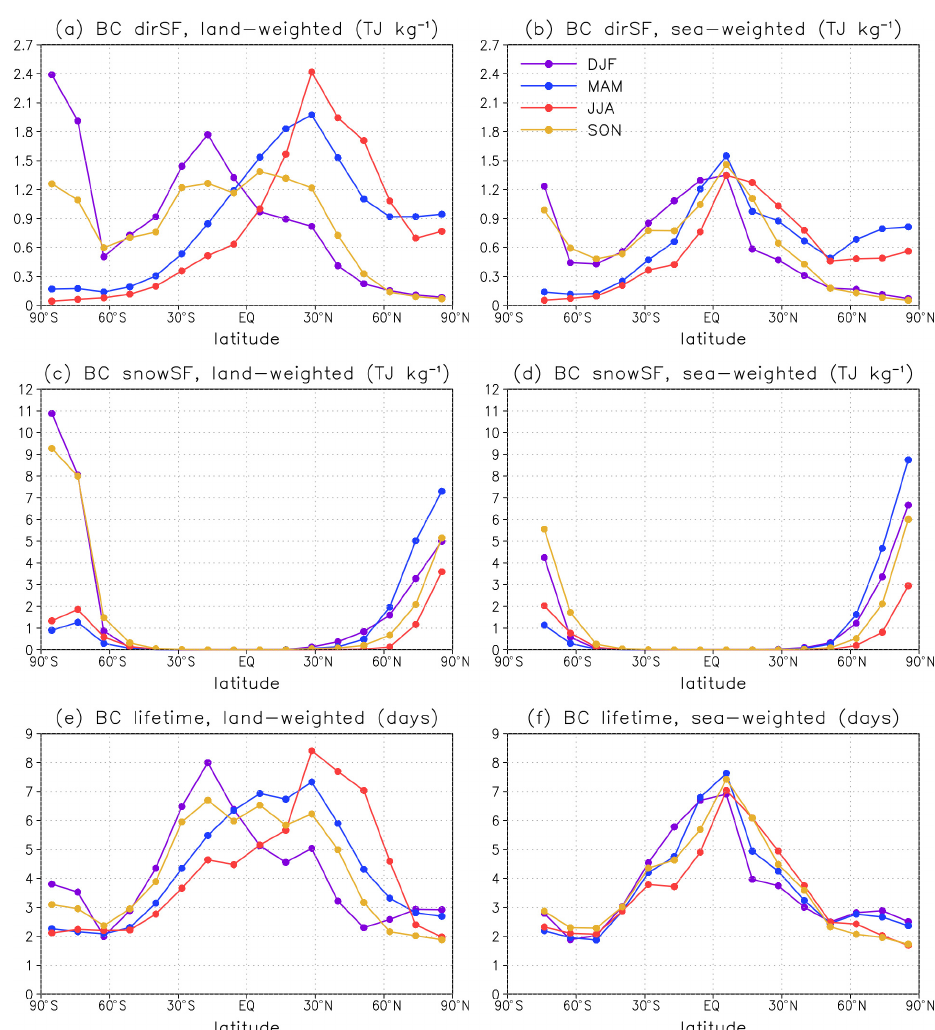
Figure 6. Global mean BC direct specific forcing (TJkg − 1 ) associated with BC emissions in different seasons, zonally averaged over the 12 emission regions per latitude band and weighted by (a) land fraction and (b) sea fraction of the emission regions. Panels (c) and (d) are the same as panels (a) and (b) but for the specific forcing due to BC in snow (TJkg − 1 ). Panels (e) and (f) are the same as panels (a) and (b) but for BC lifetime (in